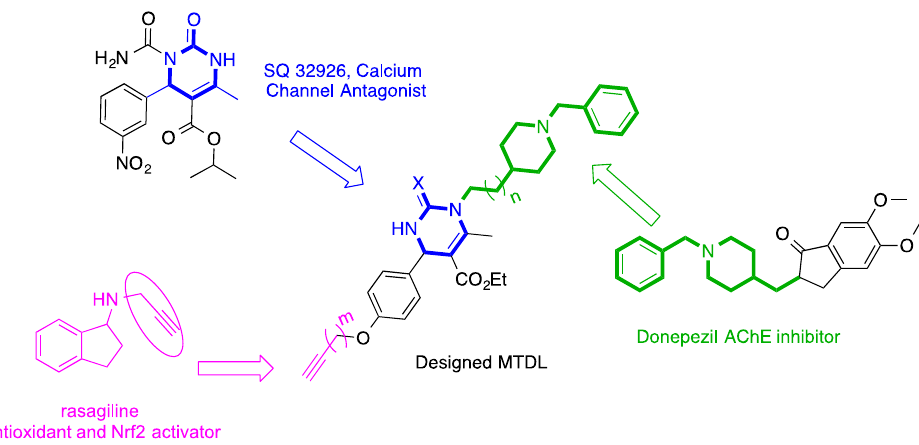
Figure 1. Design of multitarget-directed ligands BIGI 4a-d and BIGI